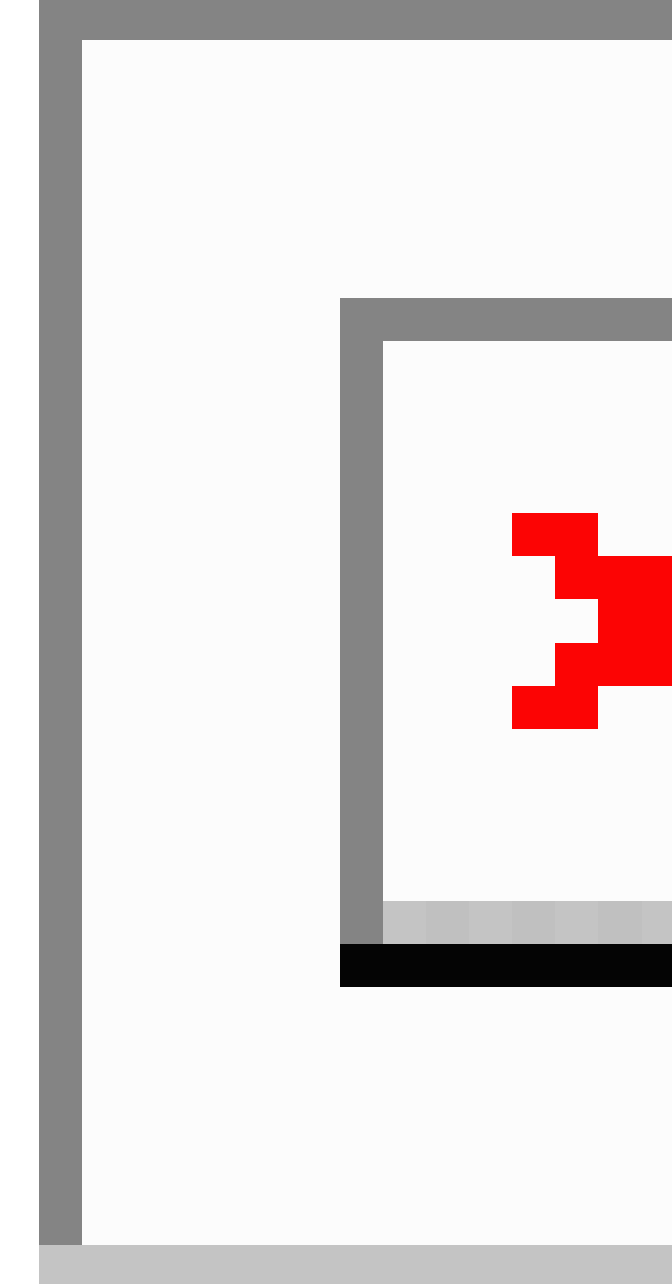
Figure 2. Arm-specific summaries of key engagement metrics (95%